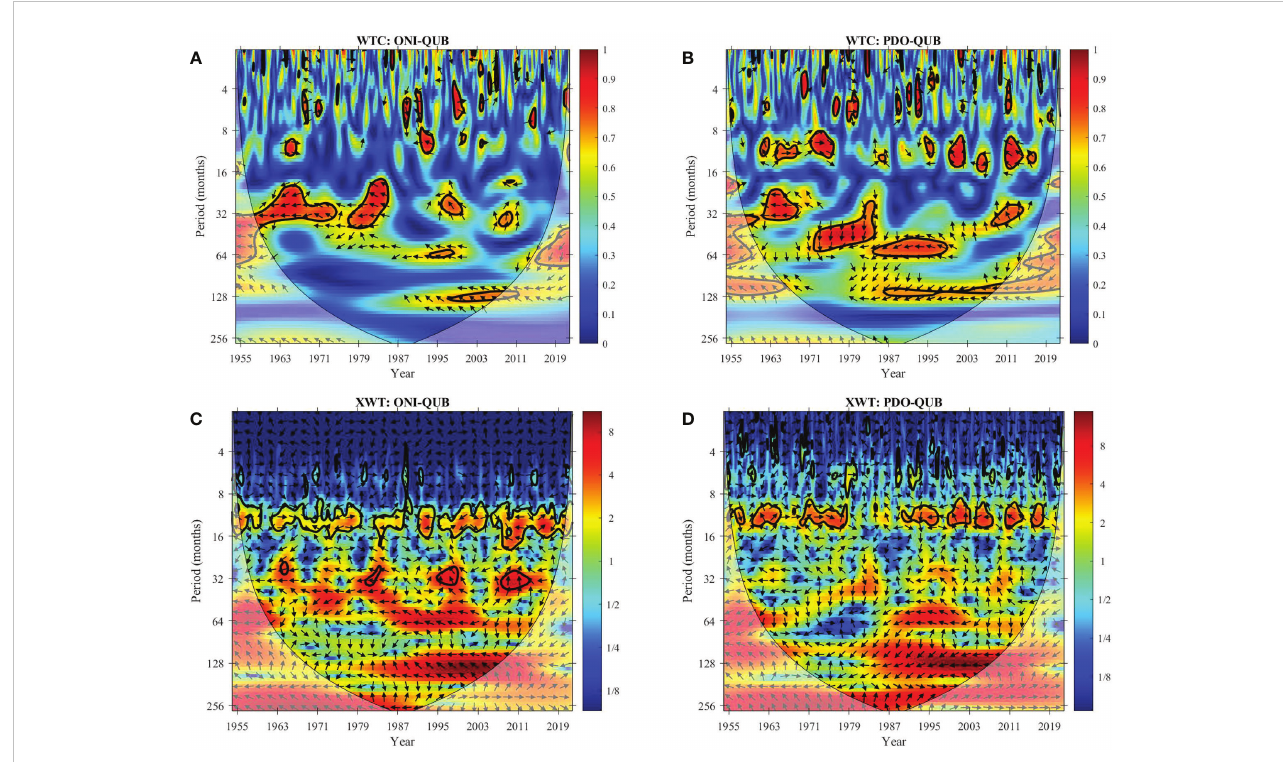
FIGURE 9 WTC and XWT spectrum of ocean-atmosphere variabilities and the RSL at QUB site. (A, B) are the WTC spectrums of ONI-QUB and PDO-QUB. (C, D) are the XWT spectrums of ONI-QUB and